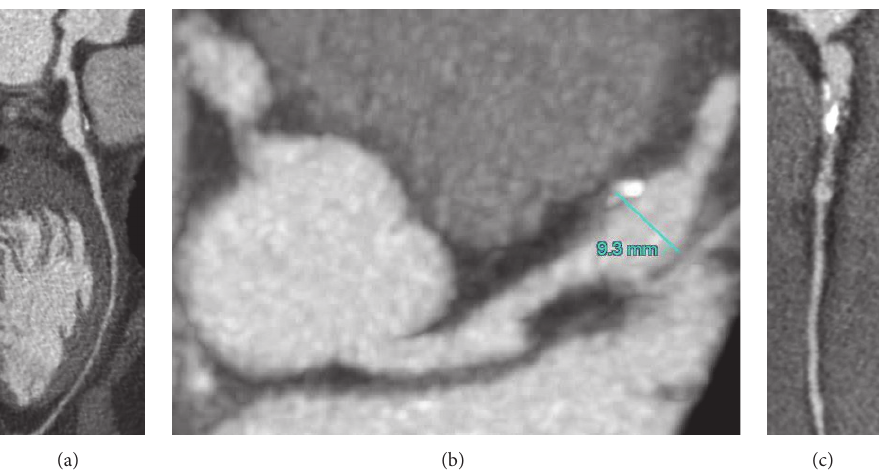
Figure 3: CT angiogram. (a) Curved multiplanar reformat image of the left anterior descending coronary artery. (b) Curved multiplanar reformat image of the right coronary artery. (c) Multiplanar reformat image demonstrating aneurysmal coronary arteries arising from aortic